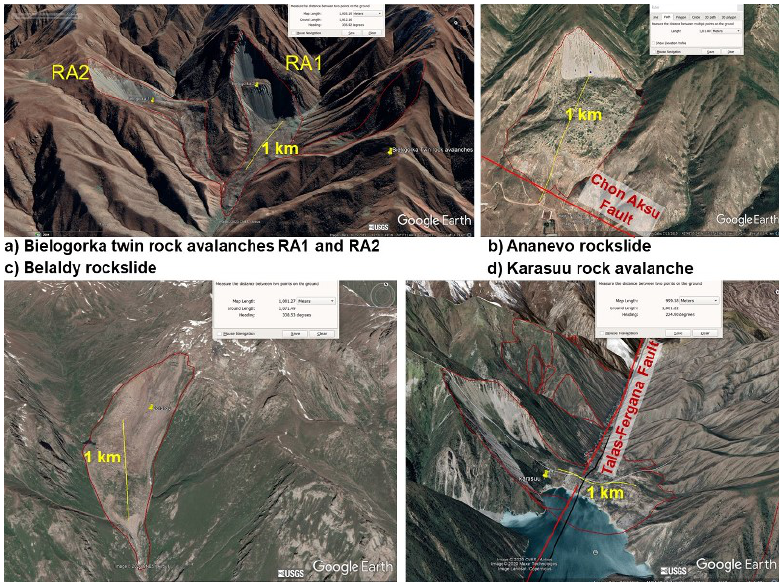
Figure 5. ( a ) Examples of ancient landslides with proven ( b , c ) and likely ( a , d ) seismic origins: ( a ) the Bielogorka twin rock avalanches RA1 and RA2 (year unknown; if related to the Belovodsk earthquake: 1885); ( b ) the Ananevo rockslide (1911); ( c ) the Belaldy rockslide (1992); ( d ) the Karasuu rock avalanche. In fact, only two of the four presented proven or likely seismically-triggered rockslides are located near or on an active fault: Ananevo and Karasuu. The Belaldy rockslide occurred quite far from the next surface rupture related to the Suusamyr event, and the Bielogorka twin rock avalanches are located in the first range of higher mountains; the surface rupture occurred in front of the range. However, as the Ananevo rockslide, both the Belaldy and Bielogorka rockslides are located in the hanging wall of the activated thrust fault and strong shaking near-fault effects can be expected for these